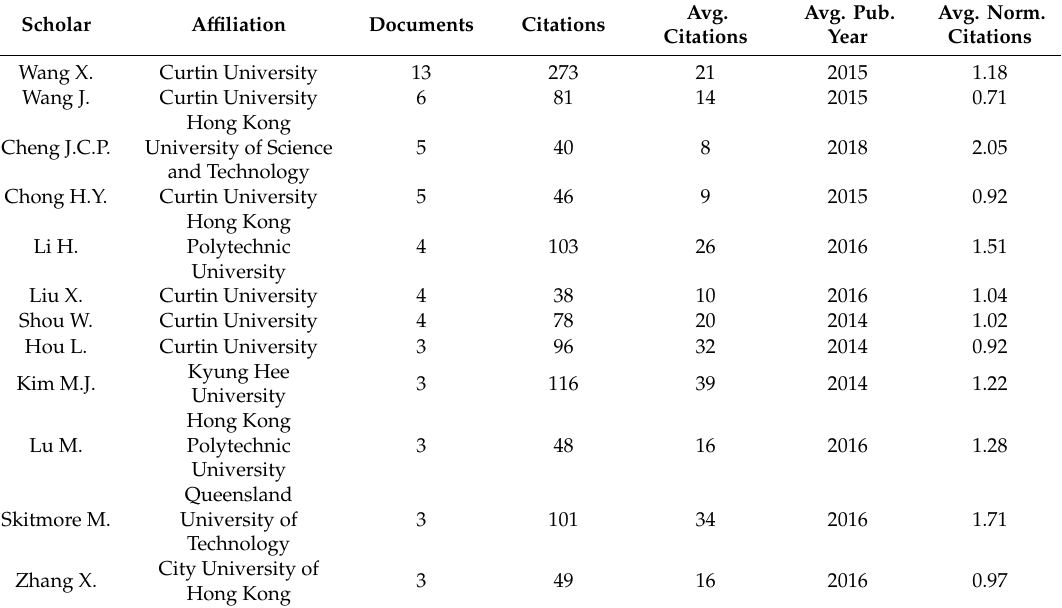
Figure 2. Co-authorship network. Table 1. Details of co-authorships.